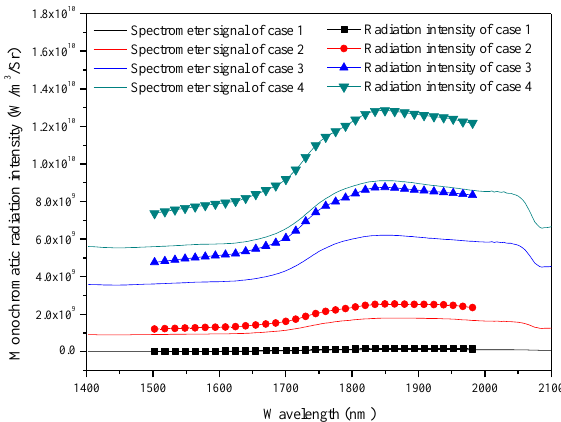
Figure 5. Time-averaged spectrometer signals of four cases.